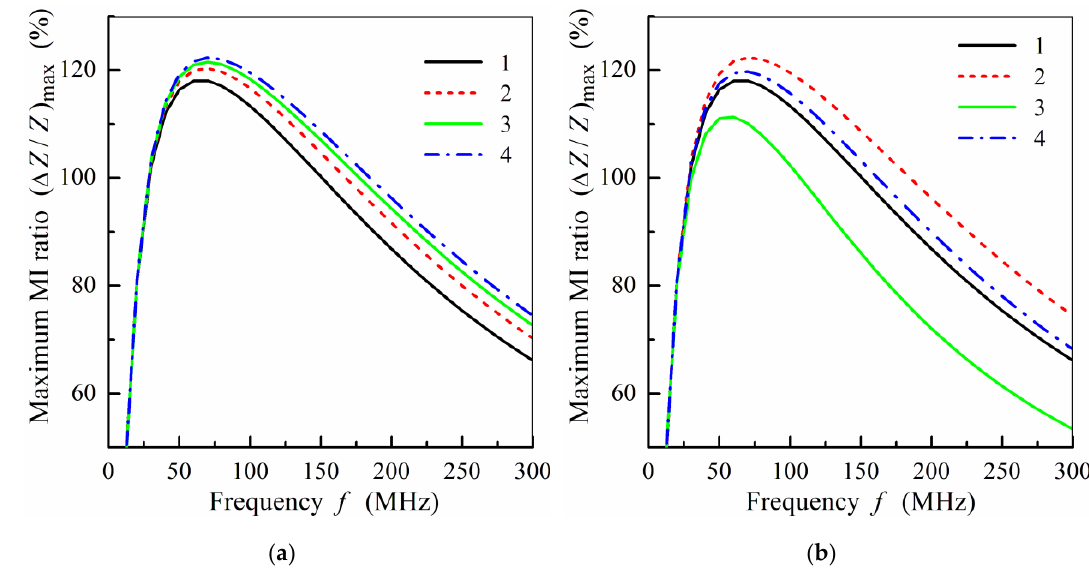
Figure 6. ( a ) Frequency dependence of the maximum MI ratio, ( ∆ Z / Z ) max , for m = 4, d 2 = 100 nm, and di ff erent values of the conductivity, σ 1 , of spacers: curve 1, σ 1 = 5 × 10 17 s − 1 ; curve 2, σ 1 = 2 × 10 17 s − 1 ; and curve 3, σ 1 = 10 17 s − 1 ; curve 4, σ 1 = 5 × 10 16 s − 1 . ( b ) Frequency dependence of the maximum MI ratio, ( ∆ Z / Z ) max , at di ff erent values of the conductivity, σ 1 , and thickness, d 1 , of spacers: curve 1, m = 4, d 2 = 100 nm, and σ 1 = 5 × 10 17 s − 1 ; curve 2, m = 4, d 2 = 100 nm, and σ 1 = 5 × 10 16 s − 1 ; curve 3, m = 9, d 2 = 50 nm, and σ 1 = 5 × 10 17 s − 1 ; curve 4, m = 9, d 2 = 50 nm, and σ 1 = 5 × 10 16 s − 1 . Other